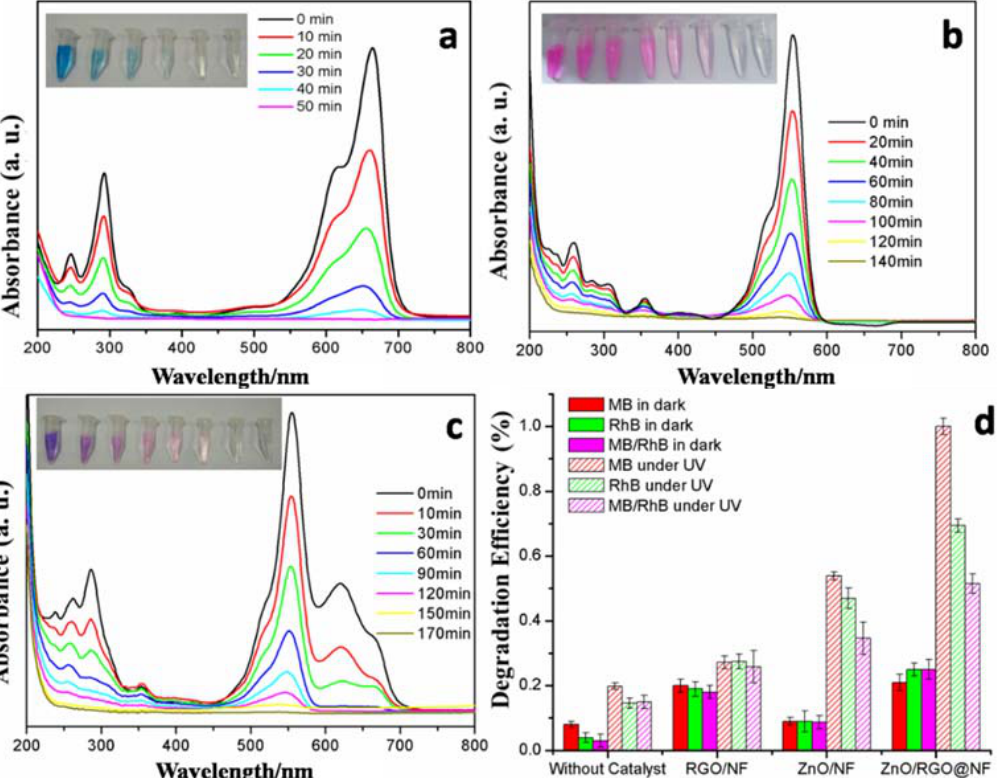
Figure 4. ( a – c ) The photocatalytic degradation process of MB (10 mg/L), RhB (10 mg/L), MB/RhB (5 mg/L/5 mg/L) mixed solutions in the presence of ZnO/RGO@NF under UV irradiation (the inset photos show the color change of different dyes solution with time); ( d ) The degradation efficiency of MB (10 mg/L), RhB (10 mg/L), and MB/RhB (5 mg/L/5 mg/L) mixed solution in the presence of different photocatalysts under UV light irradiation.